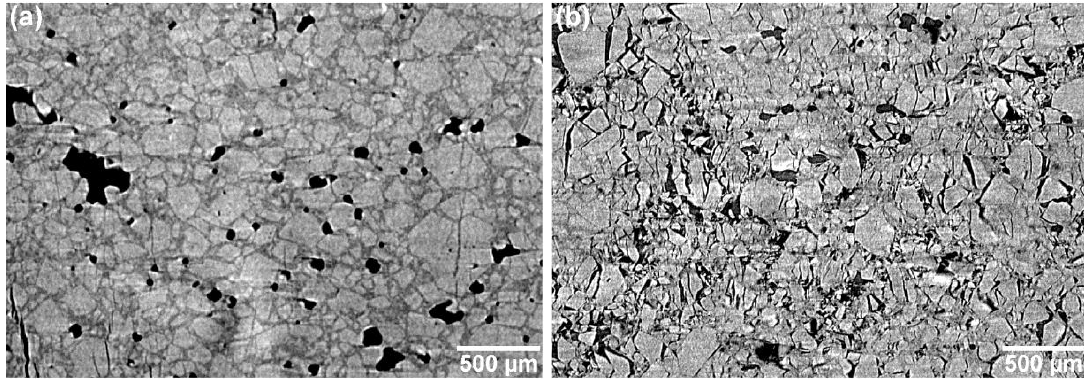
Figure 7. Selected regions of compressed CF75-AMO1 ( a ) and CF75-AMO2 ( b ) at 20% strain.